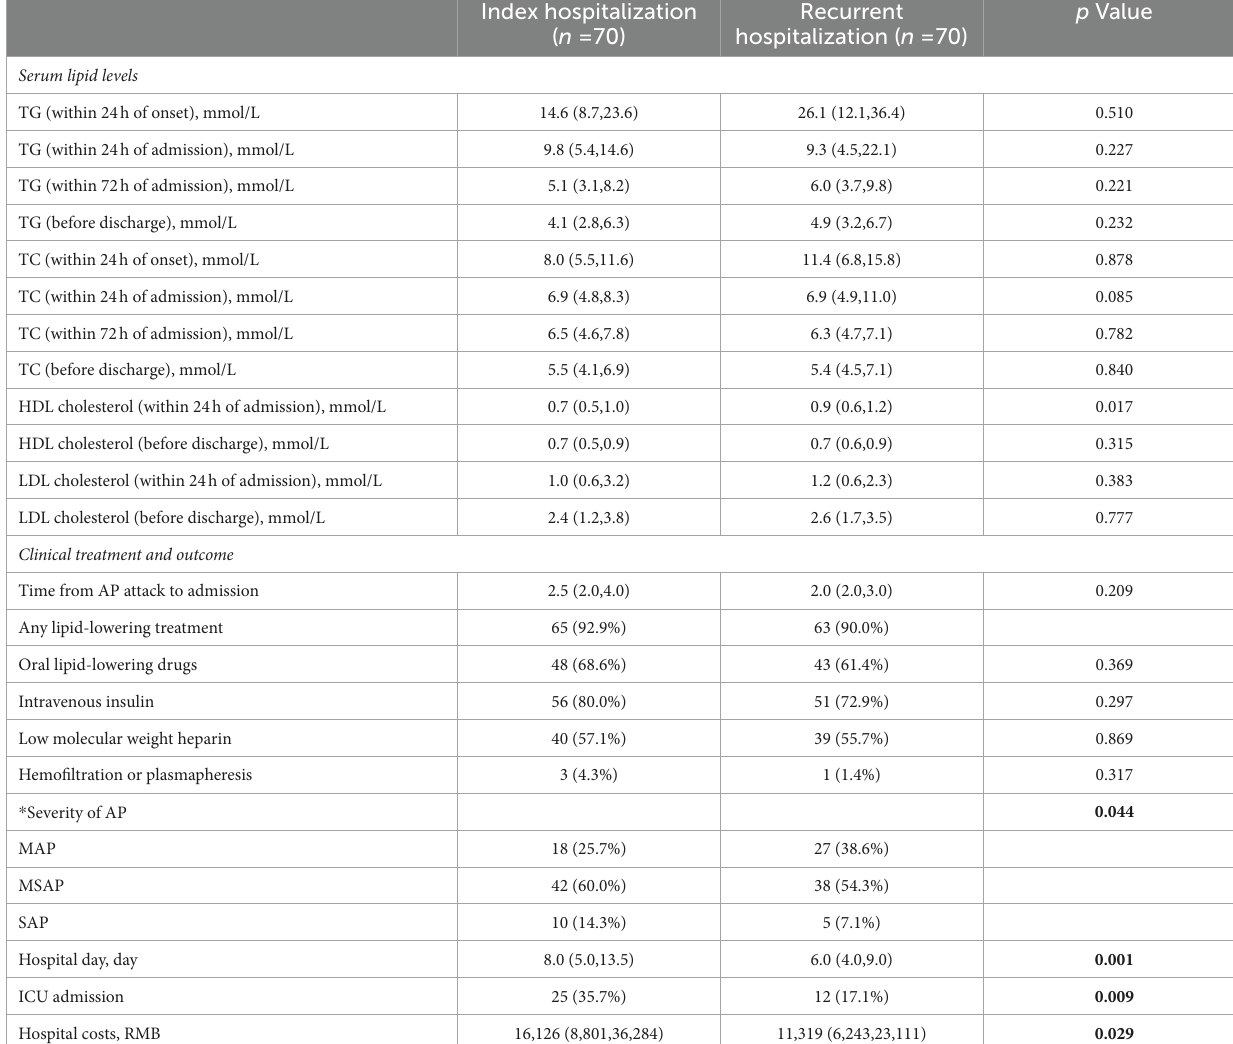
TABLE 7 Clinical profile compared between index and recurrent hospitalization in patients with